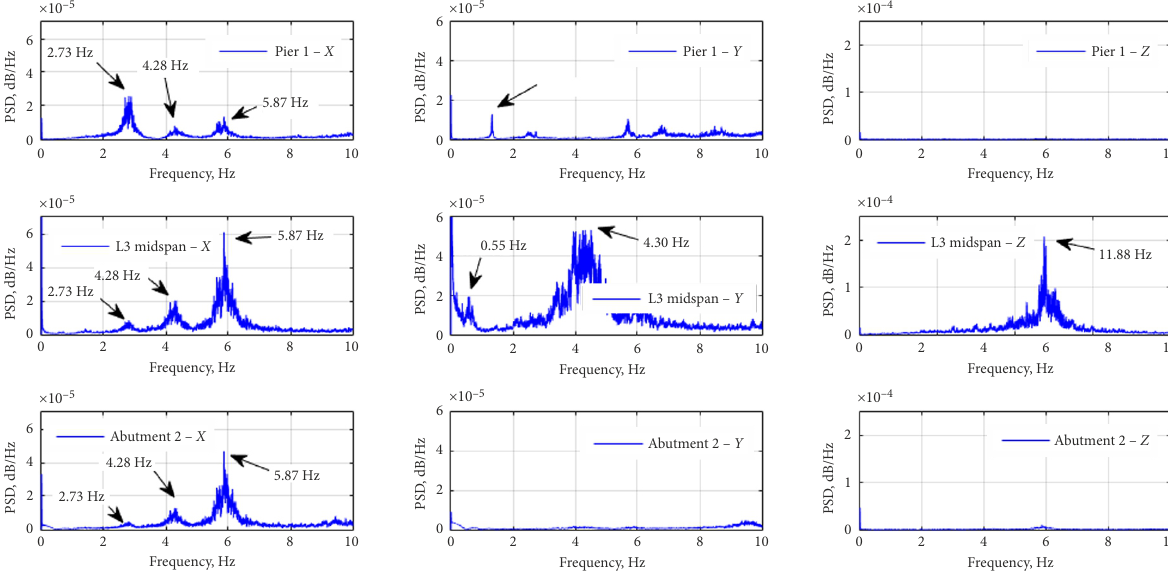
Figure 7. Frequency domain presentation of the signals for the third set of measurements in the first Ambient Vibration